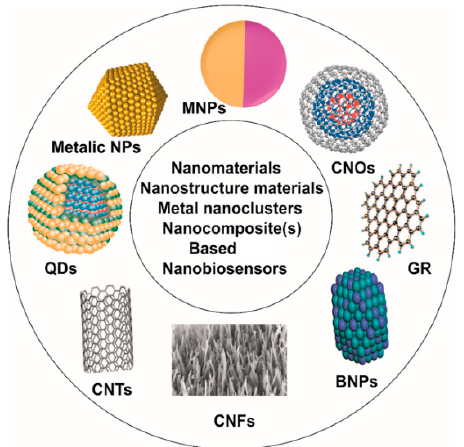
Figure 6. Most commonly used nanomaterials, metal nanoclusters, or nanocomposites for the fabri- cation of electrochemical nano-biosensors (CNFs: carbon nanofiber, BNPs: bimetallic nanoparticles, GR: graphene, CNOs: carbon nano-onions, MNPs: magnetic nanoparticles, QDs: quantum dots, CNTs: carbon nanotubes, and NPs: nanoparticles). This Figure is adapted from Rizwan and Mohd- Naim et al .